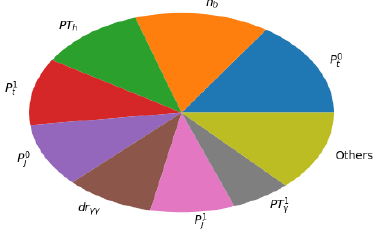
Figure 10 . RF inputs classi(cid:12)ed by their Gini importance. The \others" slice includes the 11 variables not shown explicitly.